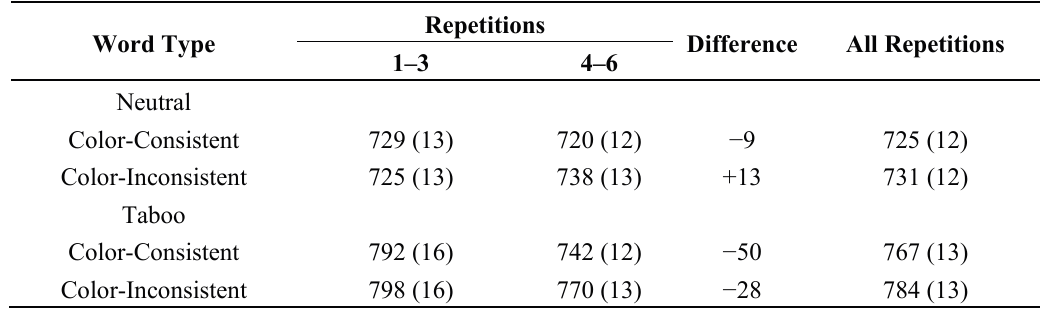
Table 2. Mean color-naming RTs for color-consistent vs. color-inconsistent words by word type and repetition in Experiment